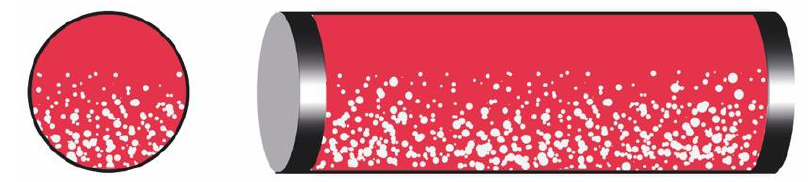
Dispersion of oil in water and water: [Do/w & W]. When the amount of water in the mixture is reduced (from Do/w), the turbulent forces in the mixture are reduced, allowing oil droplets to coalescence and grow in size. The distribution of the oil droplets is controlled by buoyancy forces, which push them to the top of the pipe, resulting in a clear (or almost transparent) water layer at the bottom [17]. Figure A2. Dispersion of oil in water and water. [Do/w & W]. Oil and dispersion of water in oil: [O & Dw/o]. This structure is divided into two dominated layers of oil and water. Oil makes up the majority of the pipe’s upper portion. The pipe’s lower portion has a dual dispersion. Over a dispersion of oil in water, a dispersion of water in oil is noticed. This dual dispersion appears as a foam-like layer due to the high amount of turbulence [17].